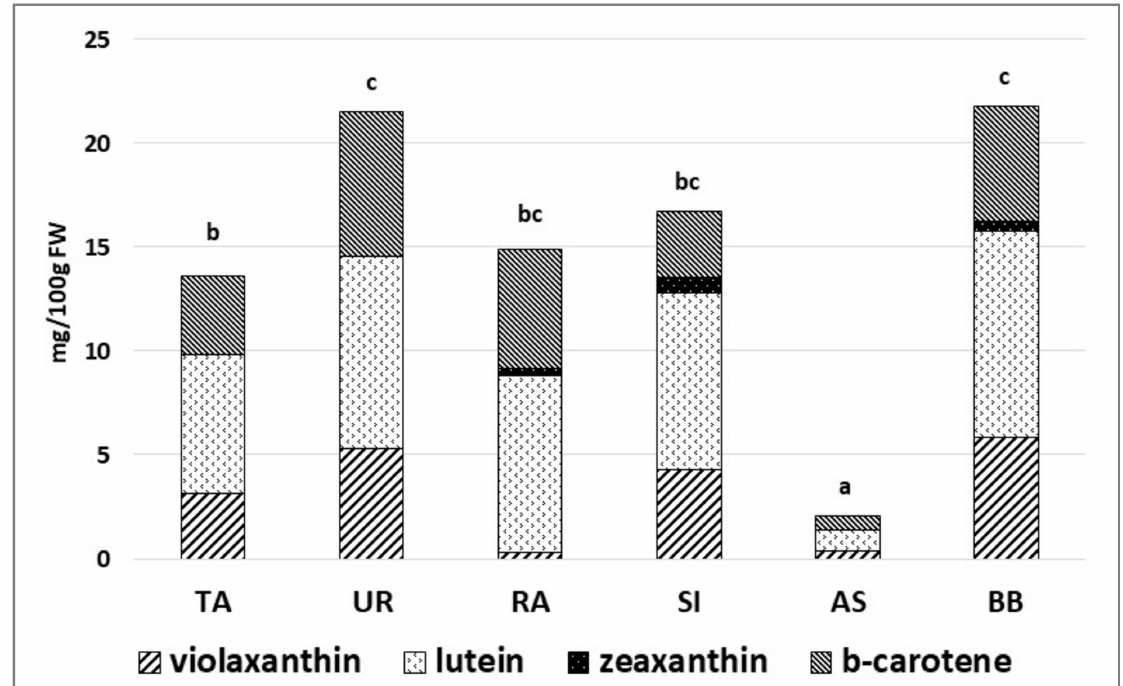
Figure 1. Total carotenoids (mg/100 g FW) in raw botanical species, analyzed in the HPLC. Bars of total carotenoid contents reporting different letters are significantly different ( p < 0.05). T. officinale (TA), U. dioica (UR), R. acetosa (RA), S. vulgaris (SI), A. dioicus (AS), B. bonus-henricus